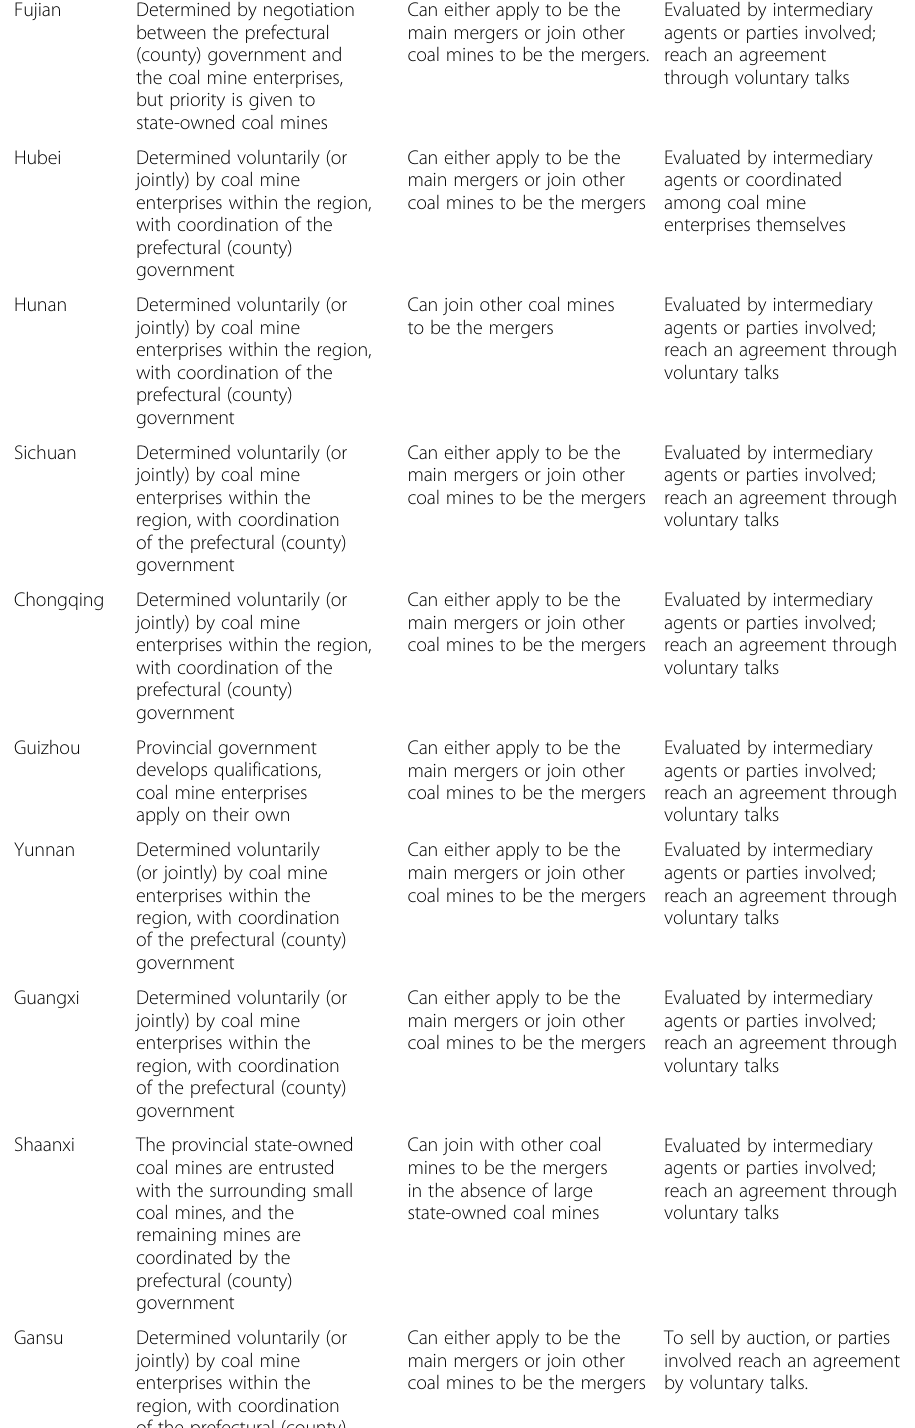
Table 2 Basic features of the mergers and reorganizations policy for each province (including autonomous regions and municipalities)